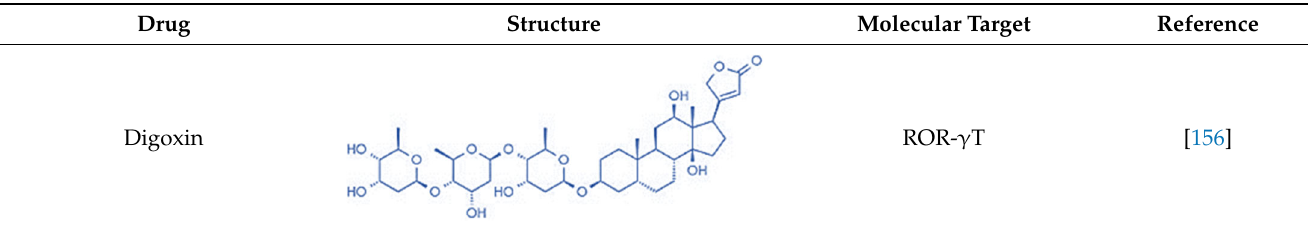
Table 3. List of drugs that can be exosomal cargo for specific targeting of Th17 cells.